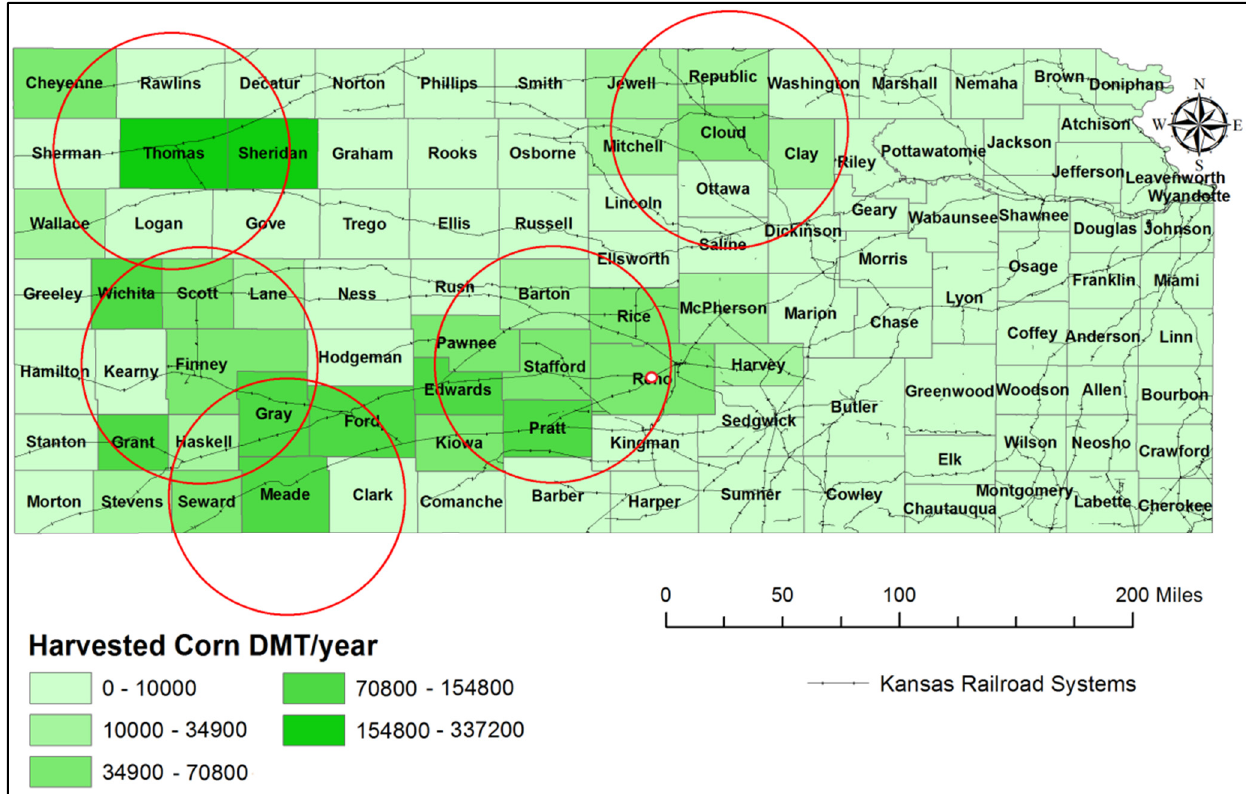
Figure 3. Scenario 2 depot configuration based on biomass density and infrastructure availability. The red circle shows the biomass supply radius. The depots are located at the center of the circle and receive the feedstock from counties within an 80-km (50-miles) radius. The red point at the centroid of Reno County corresponds to the location of the